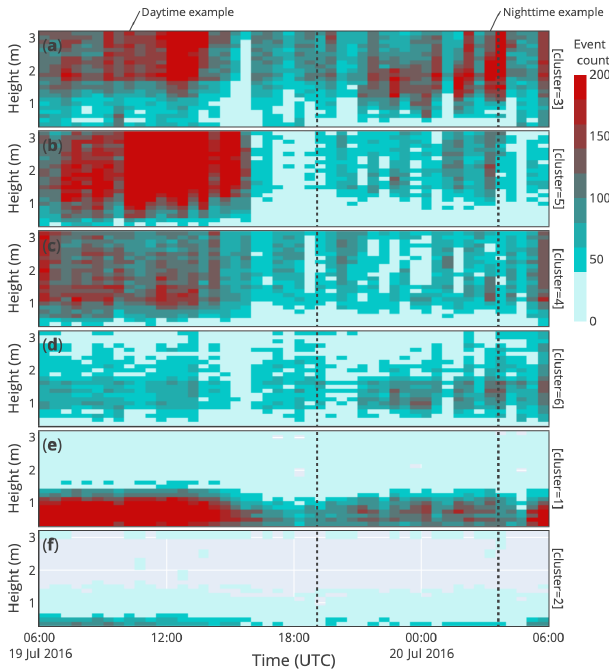
Figure 8. Shown for each TED-determined cluster are the num- ber of events per 30min time interval and height. The clusters are ranked according to frequency, with the least frequent in the bottom